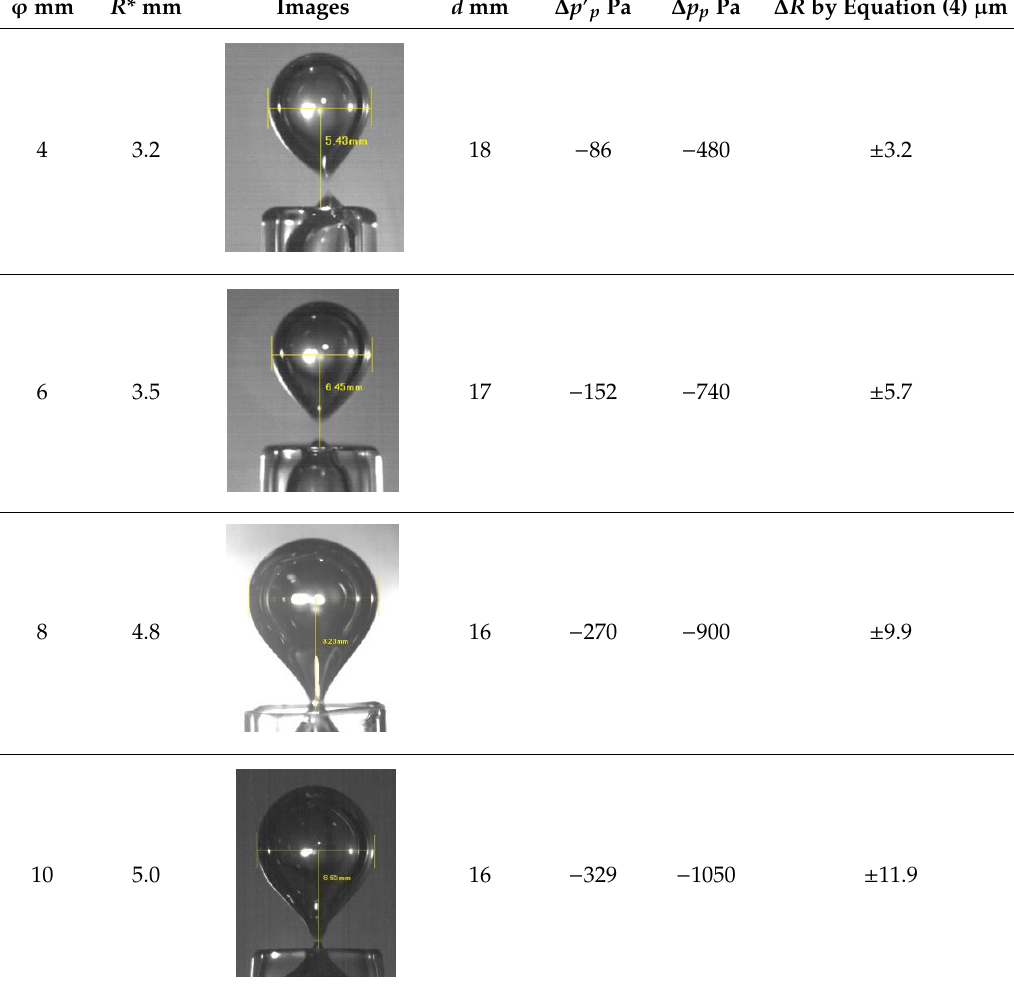
Table 2. Estimated pressure drop and radius variation.